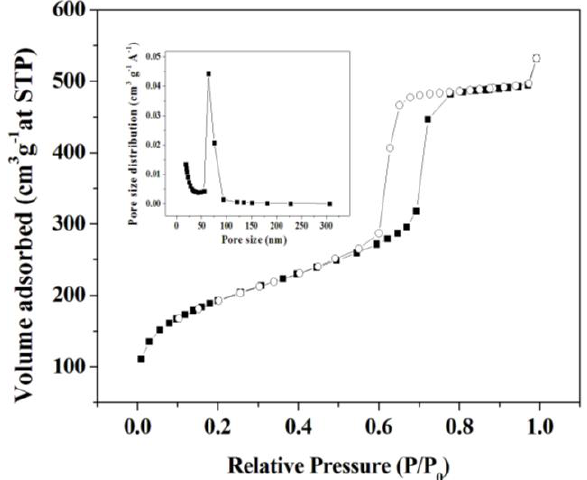
Figure 2. Nitrogen adsorption-desorption isotherms and BJH pore size distributions of mesoporous silica SBA-15: adsorption curve (  ) and desorption curve ( 